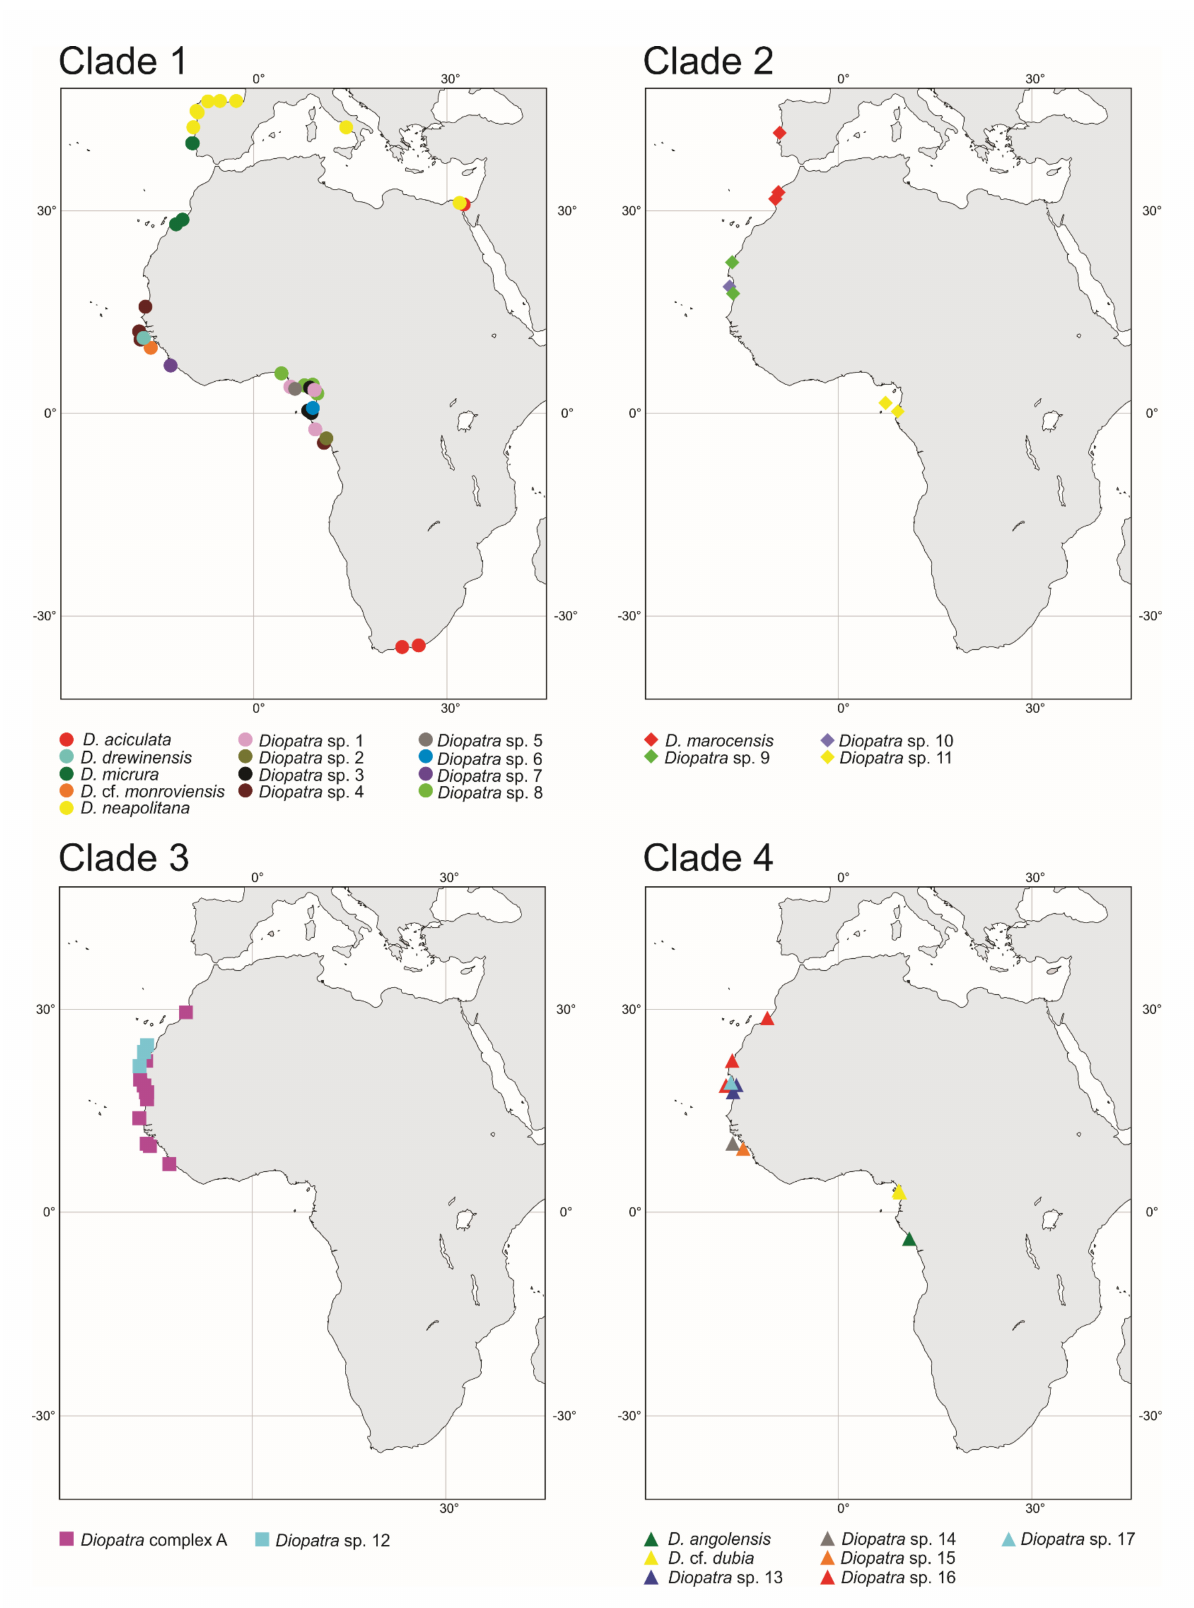
Figure 7. Distribution of Diopatra species in East Atlantic waters treated in the present study. The species are grouped by clade numbers (see Figure 1). The distribution of Diopatra aciculata and Diopatra neapolitana in the study area is based on Elgetany et al.